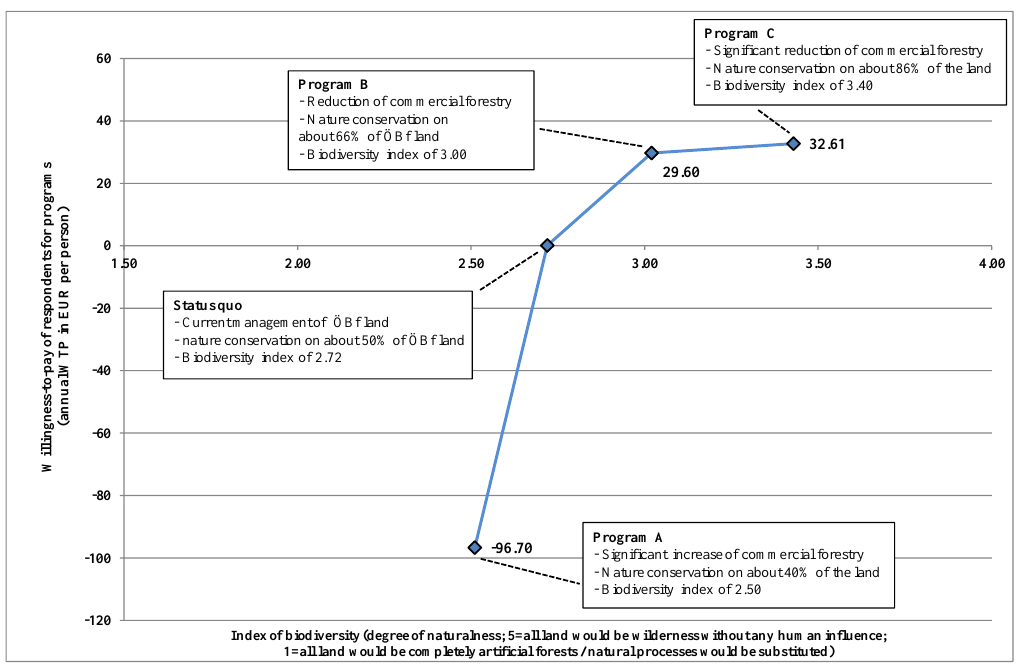
Figure 5. Relation between willingness to pay (willingness to accept) of forestry and nature conservation programs and the index of biodiversity (naturalness) achieved by the programs. ÖBf: the Austrian Federal Forests.